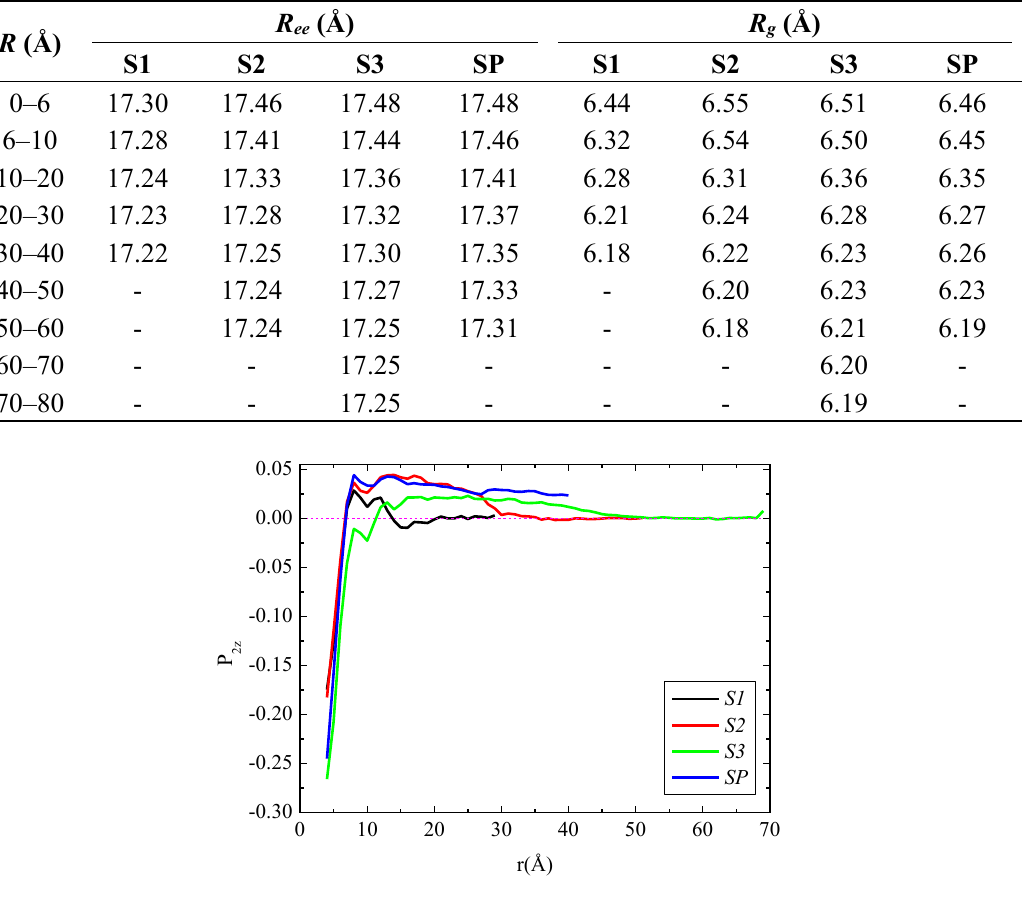
Figure 4. Second rank bond order parameter P 2 (cosθ) of polyethylene for v 1−3 vector as a function of R distance (distance from the center of the graphene layer) for all polymer/graphene nanocomposite systems studied